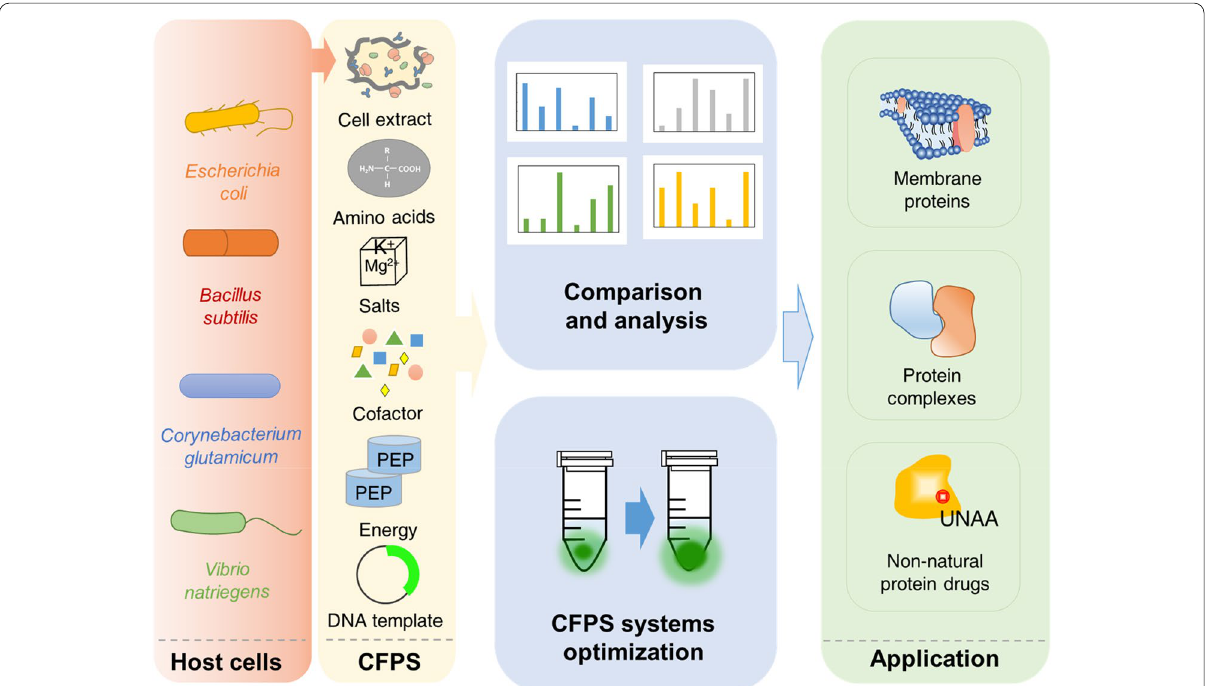
Fig. 1 The CFPS system as a platform for basic scientific research, preliminary screening and related